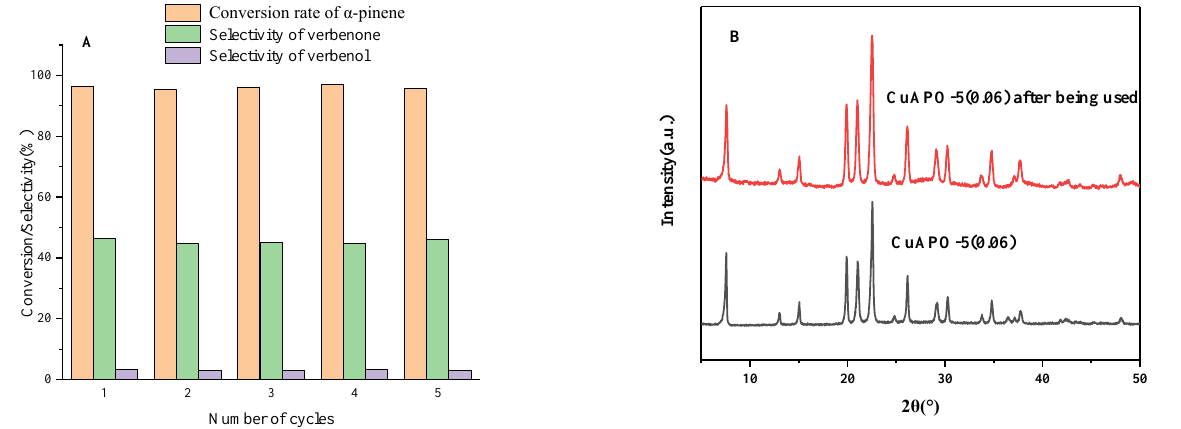
Figure 8. Effect of catalyst amount on the synt hesis of verbenenone from α -pinene. Reaction con- ditions: α -pinene 1 mmol, 3 mmol of TBHP, temperature 85 °C, TCM 10 mL, reaction 12 h. conditions: α -pinene 1 mmol, 3 mmol of TBHP, temperature 85 ◦ C, TCM 10 mL, reaction 12 h.